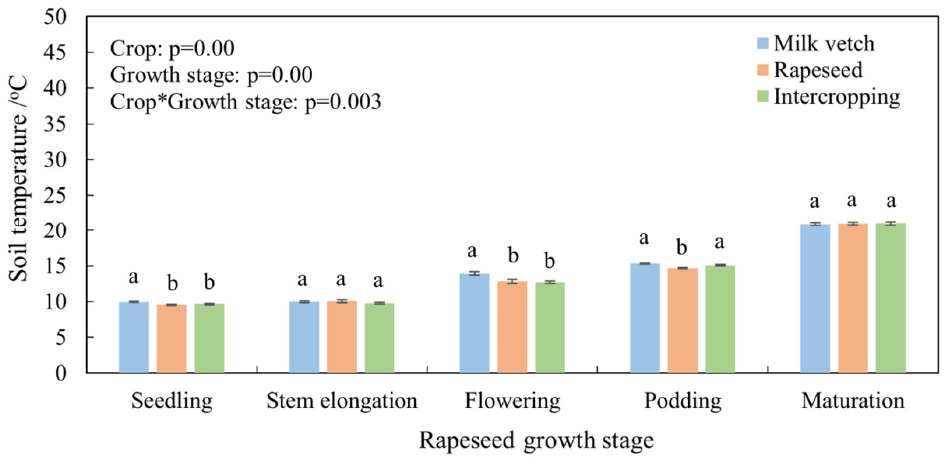
Figure 1. Changes in soil temperature during rapeseed growth stages. Crop represents crop planting patterns (Milk vetch, Rapeseed, Intercropping), Growth stage represents crop growth stages (seeding, stem elongating, flowering, podding, maturation), and Crop*Growth stage represents the interaction between planting pattern and growth stage. Milk vetch represents monoculture milk vetch; Rapeseed represents monoculture rapeseed; Intercropping represents milk vetch intercropping with rapeseed (the same below). Letters represent the significant differences ( p < 0.05) between crops at each growth stage.